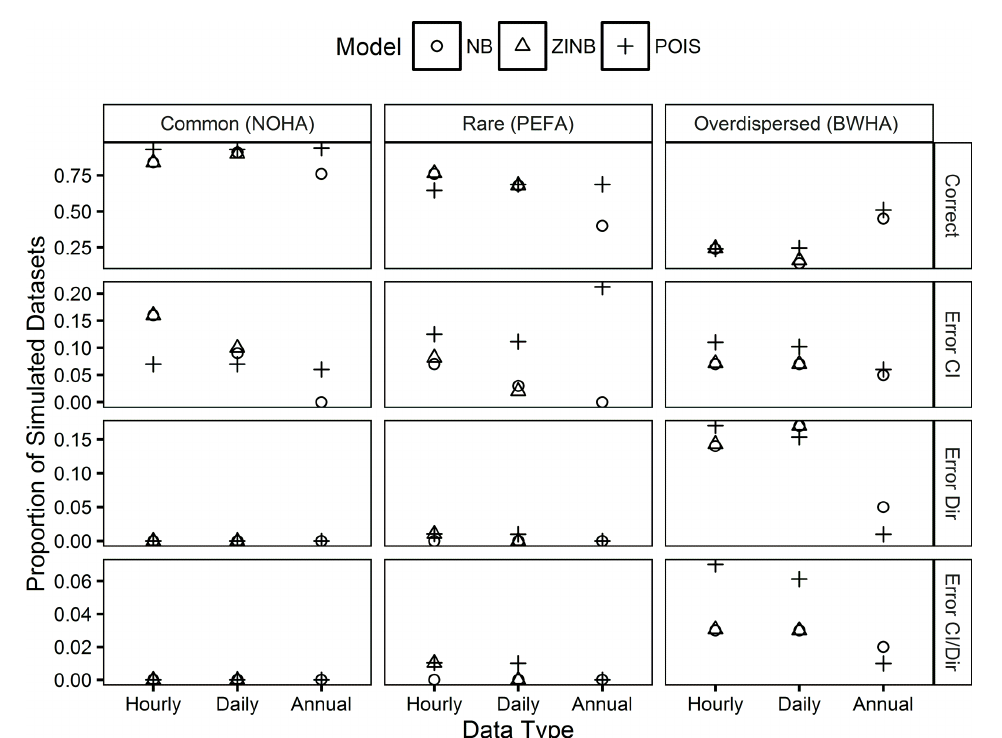
Fig. 3 . Proportion of 100 simulated datasets where (1) simulated trend fell within the 95% credible intervals (CI) of the estimated trend and CI did not include zero (“Correct”); (2) simulated trend fell outside the CI of the estimated trend (inaccurate; “Error CI”); (3) estimated trend was positive, i.e., in the wrong direction (“Error Dir”); and (4) estimated trend was in the wrong direction and credible intervals did not include the simulated trend (“Error CI/Dir”). Results are shown for data simulated to represent a commonly detected species (e.g., Northern Harrier, Circus cyaneus , NOHA), a rarely detected species with zero-inflated counts (e.g., Peregrine Falcon, Falco peregrinus , PEFA), and a super-flocking species with highly overdispersed counts (e.g., Broad- winged Hawk, Buteo platypterus , BWHA), analyzed as hourly, daily, or annual counts, and fit assuming either a negative binomial (NB) or zero-inflated NB (ZINB; hourly and daily data only), or Poisson (POIS) data